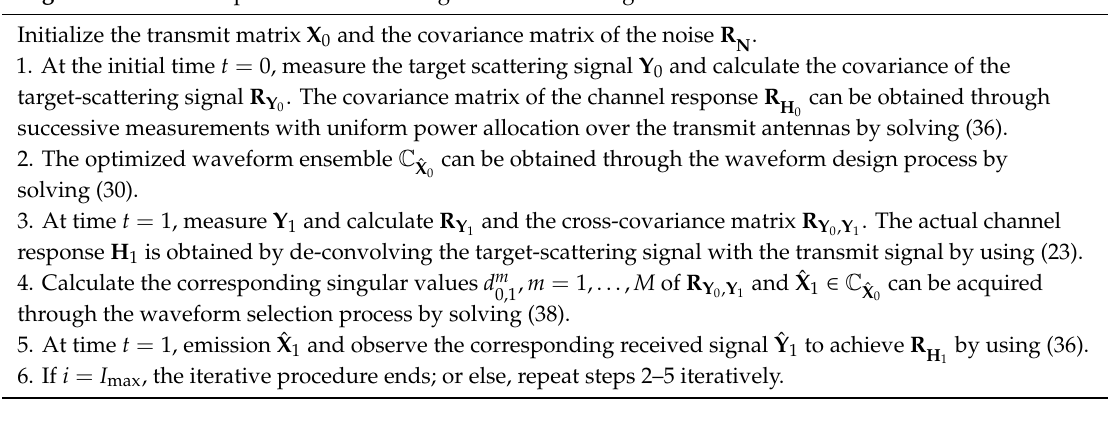
Algorithm 1 . The adaptive waveform design and selection